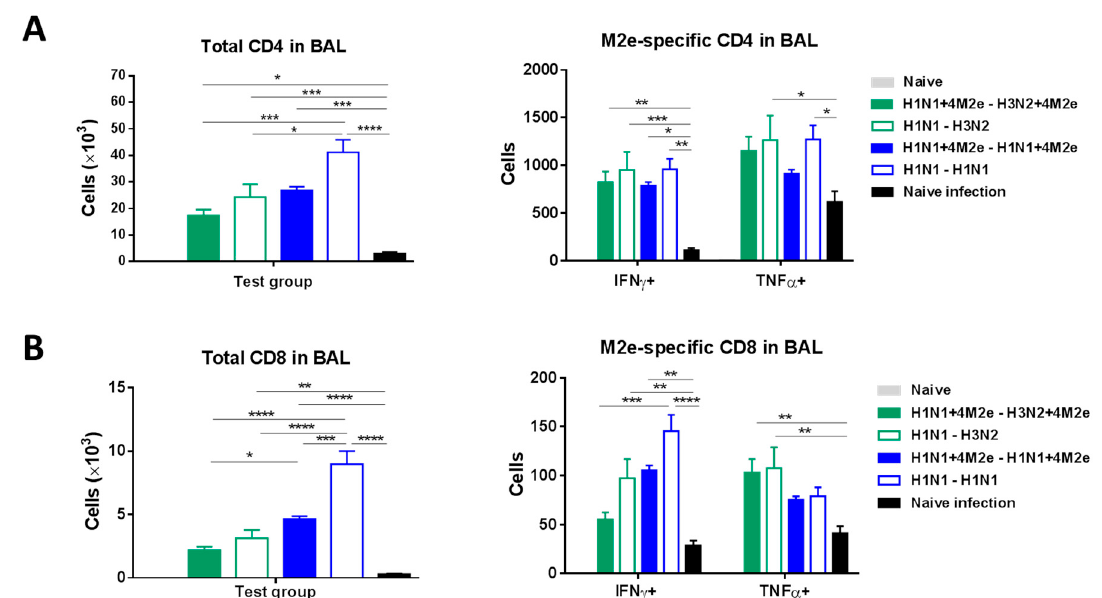
Figure 9. CD4 ( A ) and CD8 ( B ) T-cell responses in the airway BAL fluids of LAIV-vaccinated mice and naïve mice at day 5 after infection with heterologous rgH5N1 challenge virus. The left panel shows total number of cells in BAL. The right panel shows numbers of cytokine-producing cells after in vitro stimulation with human M2e peptide. Data were compared with one-way (left panel) or two-way (right panel) ANOVA followed by Tukey’s multiple comparisons test (* p < 0.05, ** p < 0.01, *** p < 0.001, **** p < 0.0001).